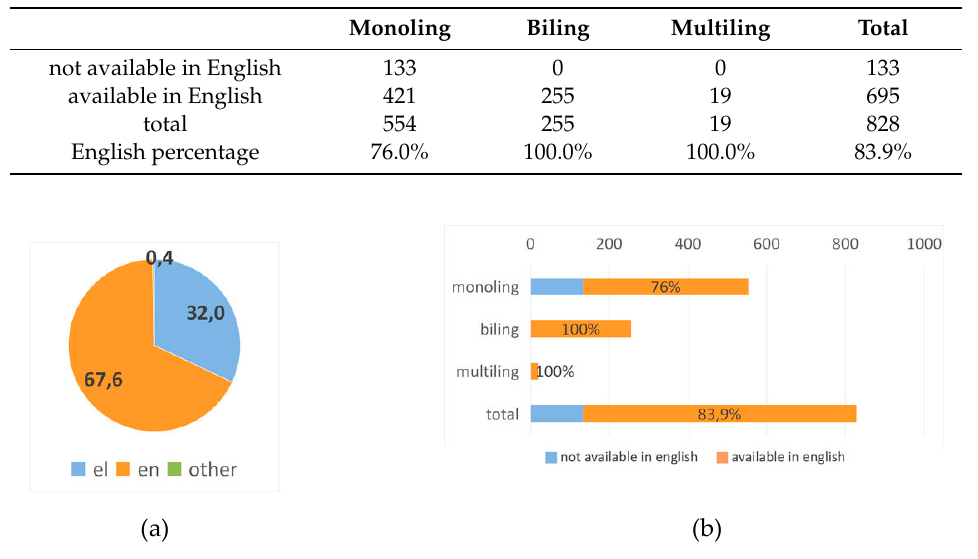
Table A10. English language availability (cy).